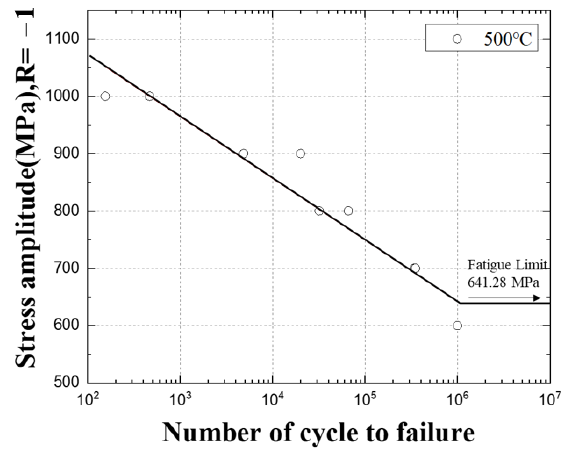
Figure 17. The S–N curve of SKD61 at 500 ◦ C. Figure 17. T he S–N curve of SKD61 at 500 °C.